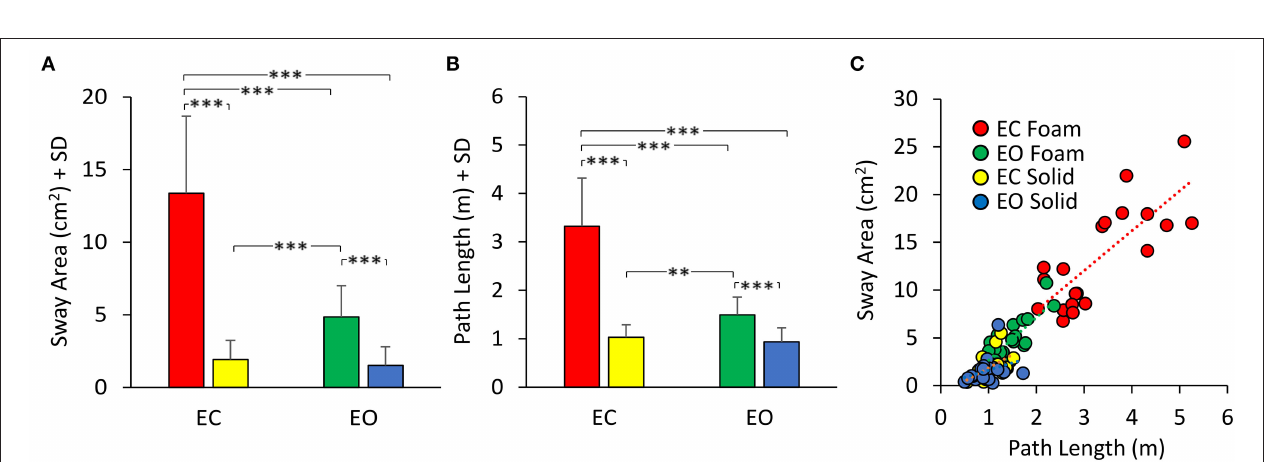
FIGURE 2 | Mean Sway Area (A) and Path Length (B) . Sway Area and Path Length are greater in Foam (EC, red; EO, green) than in Solid support condition (EC, yellow; EO, blue). Vision has a greater effect with Foam than Solid support for both Sway Area and Path Length. (C) the relationship between Sway Area and Path Length is shown for all visual and support conditions. Each dot corresponds to a subject. Asterisks indicate significant differences (** p < 0.01, *** p < 0.001).